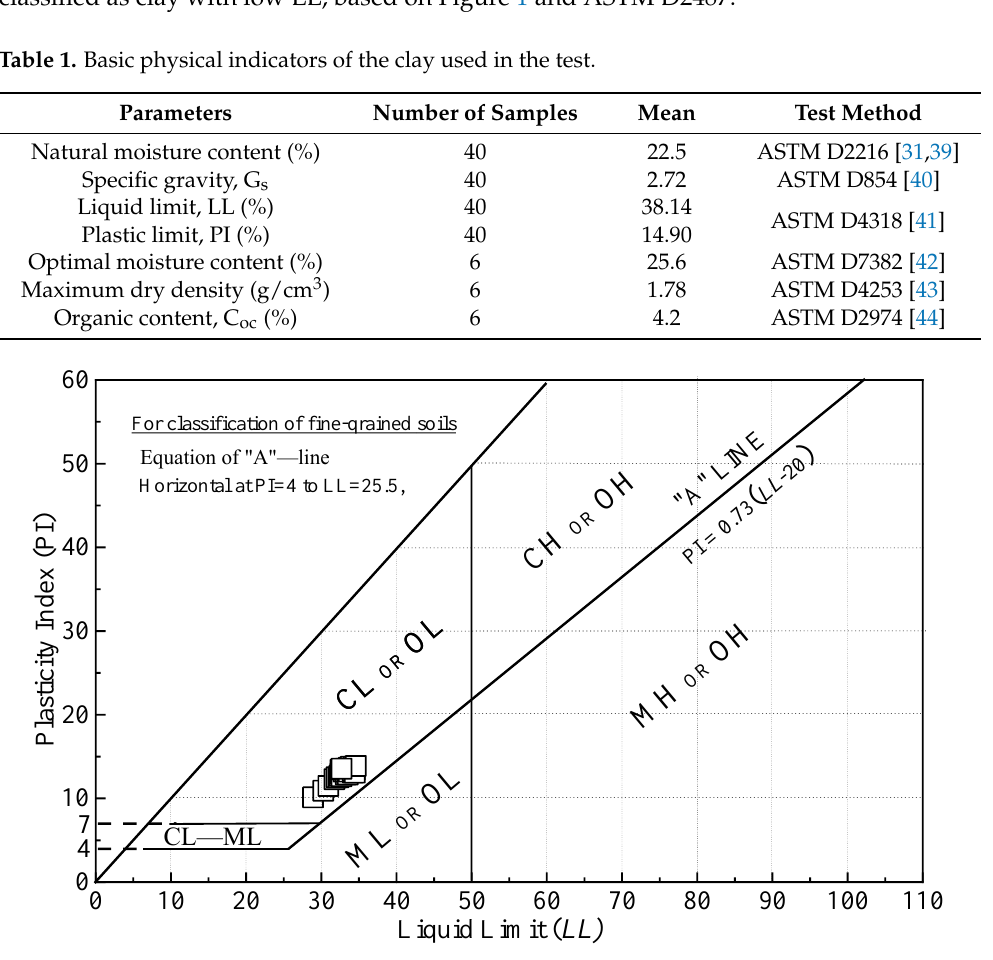
Figure 1. Plasticity chart for classification of fine-grained